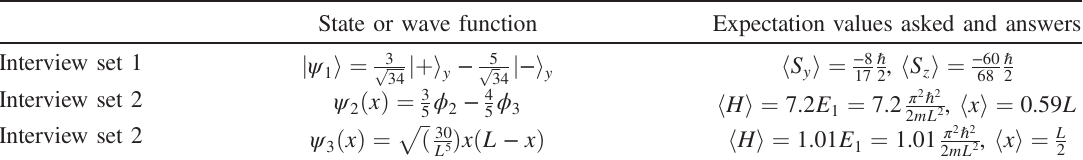
TABLE I. A list of the states or wave functions given to students during the interviews along with the expectation values they were asked to calculate. The answers for h x i for both wave functions were given to students. ϕ n in ψ 2 refers to the energy eigenstates for the infinite square well potential. E 1 ¼ π 2 ℏ 2 = 2 mL 2 was given as part of telling the students the results of the expectation values of